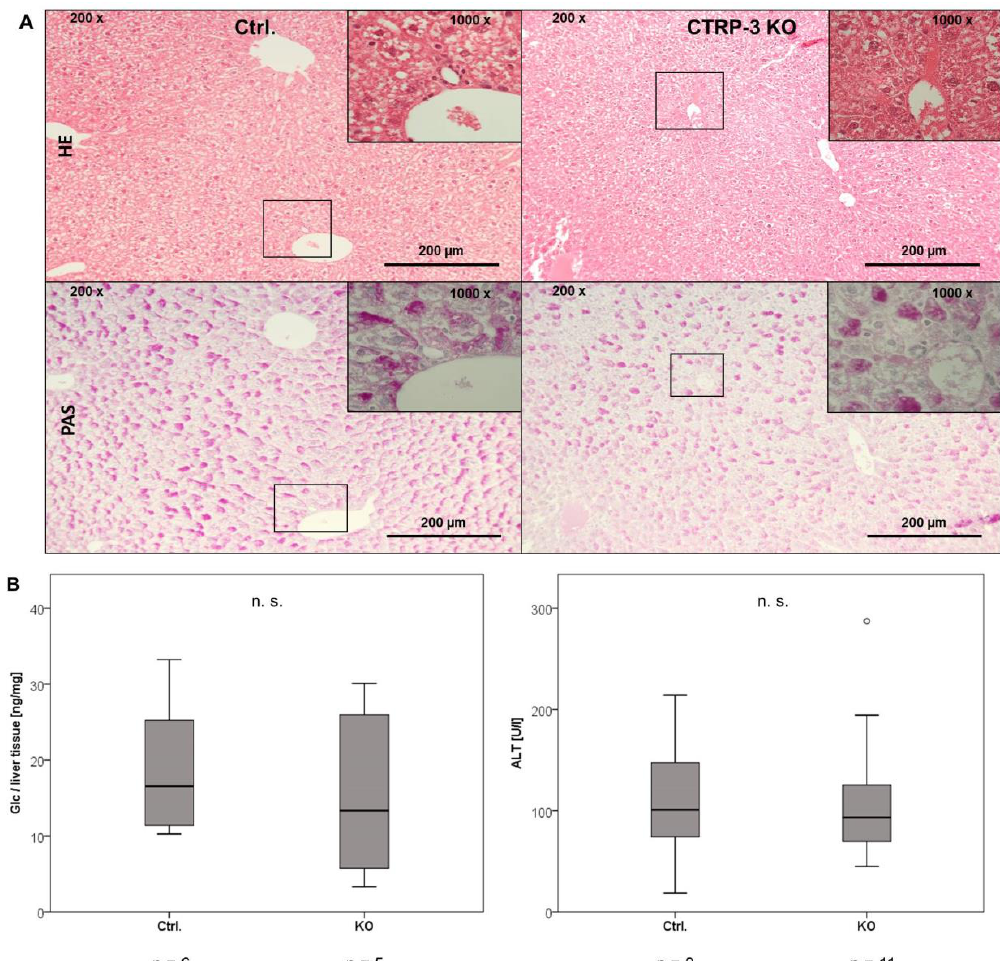
Figure 4. Histologic examination of liver cell morphology, glycogen content, and cell damage. Panel ( A ): Hepatic cell morphology (HE staining, light microscopy: 200× and 1000×) and glycogen storage (PAS staining, light microscopy: 200× and 1000×) is shown in control vs. KO animals. Panel ( B ): Quantitative analysis of liver glycogen content (quantification of supernatant glucose / liver tissue mass (ng/mg)) and serum ALT (U/L). ALT, alanine aminotransferase; Ctrl., control animals; Glc, glucose; HE, hematoxylin – eosin; KO, CTRP-3 knockout animals; PAS, periodic acid – Schiff reaction). °, out-lier